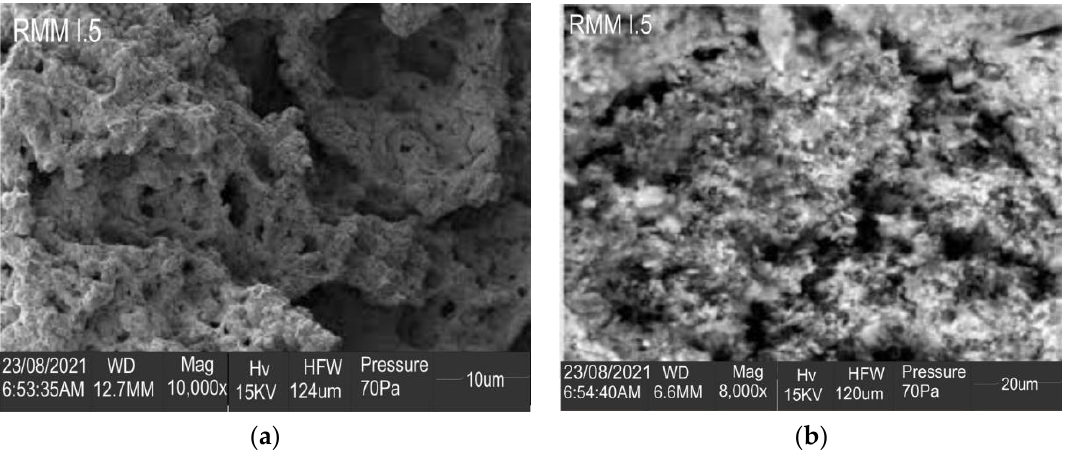
Figure 8. SEM of best fibre-reinforced mortar mix ( a ) at 7 days ( b ) at 28 days.